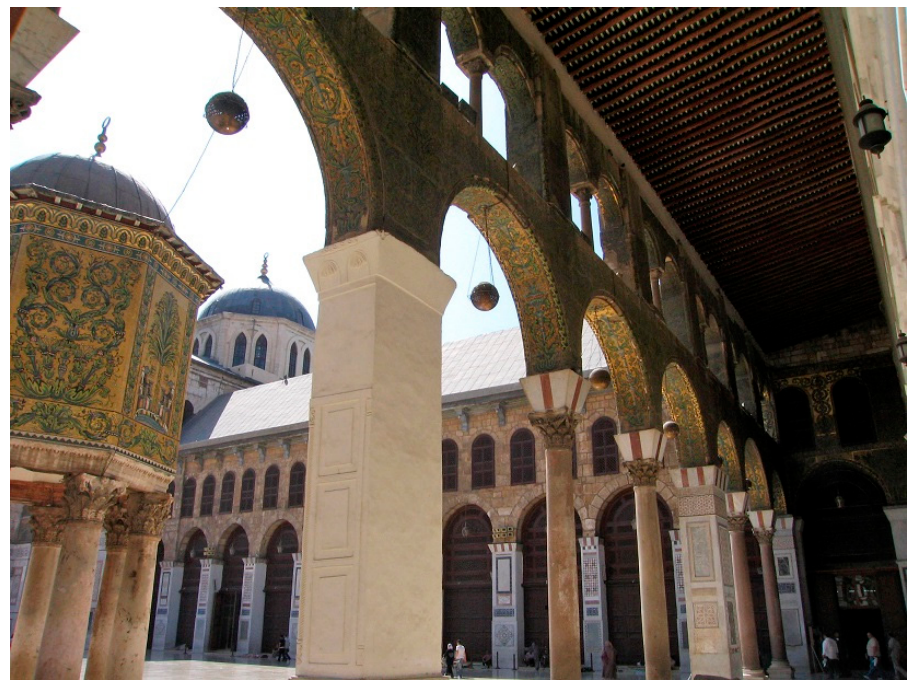
Figure 2. Umayyad mosque of Damascus (8th century). © Photo took by author.